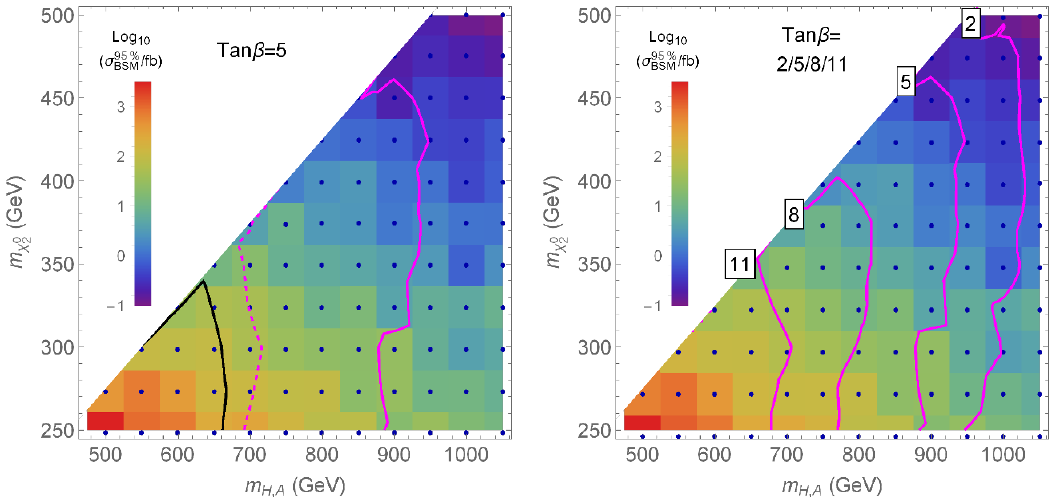
Figure 6 . Left panel : the projected 2- (cid:27) exclusion (solid contours) and 5- (cid:27) discovery lines (dashed contours) at the 13 TeV LHC with integrated luminosities of 300 fb (cid:0) 1 (black curves) and 3000 fb (cid:0) 1 (magenta curves) for tan (cid:12) = 5. Right panel : the projected 2- (cid:27) exclusion with 3000 fb (cid:0) 1 data for various tan (cid:12) values (indicated by the contour labels). For both panels, blue dots indicate simulated signal benchmark points for this analysis, with the colors on each benchmark point tile representing the projected upper limit on the cross section from our analysis for tan (cid:12) = 5 as indicated in the plot legend. For the two panels, we (cid:12)x m (cid:31) = m (cid:31) = m (cid:31) + 100 3 2 1